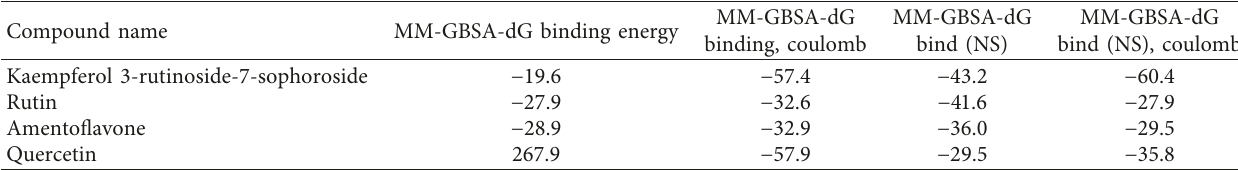
Table 4: The relative binding-free energies (kcal/mol) obtained by prime